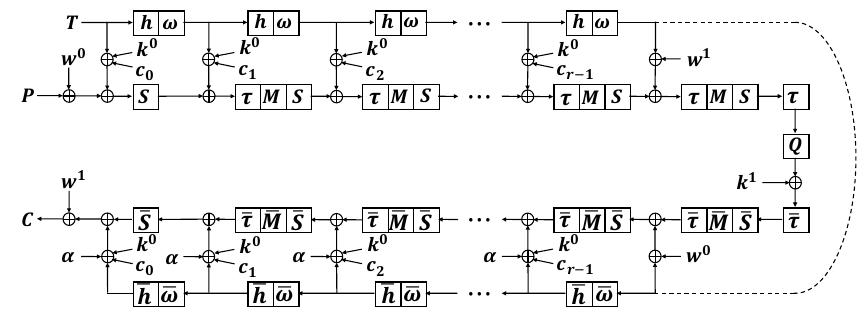
Figure 1: The Structure of (2 r + 2)-Round